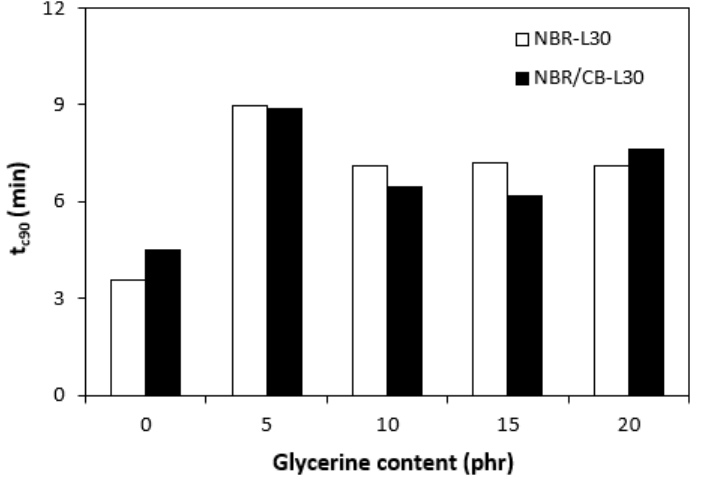
Figure 7. Influence of glycerine contents on optimum cure times t c90 of rubber compounds.